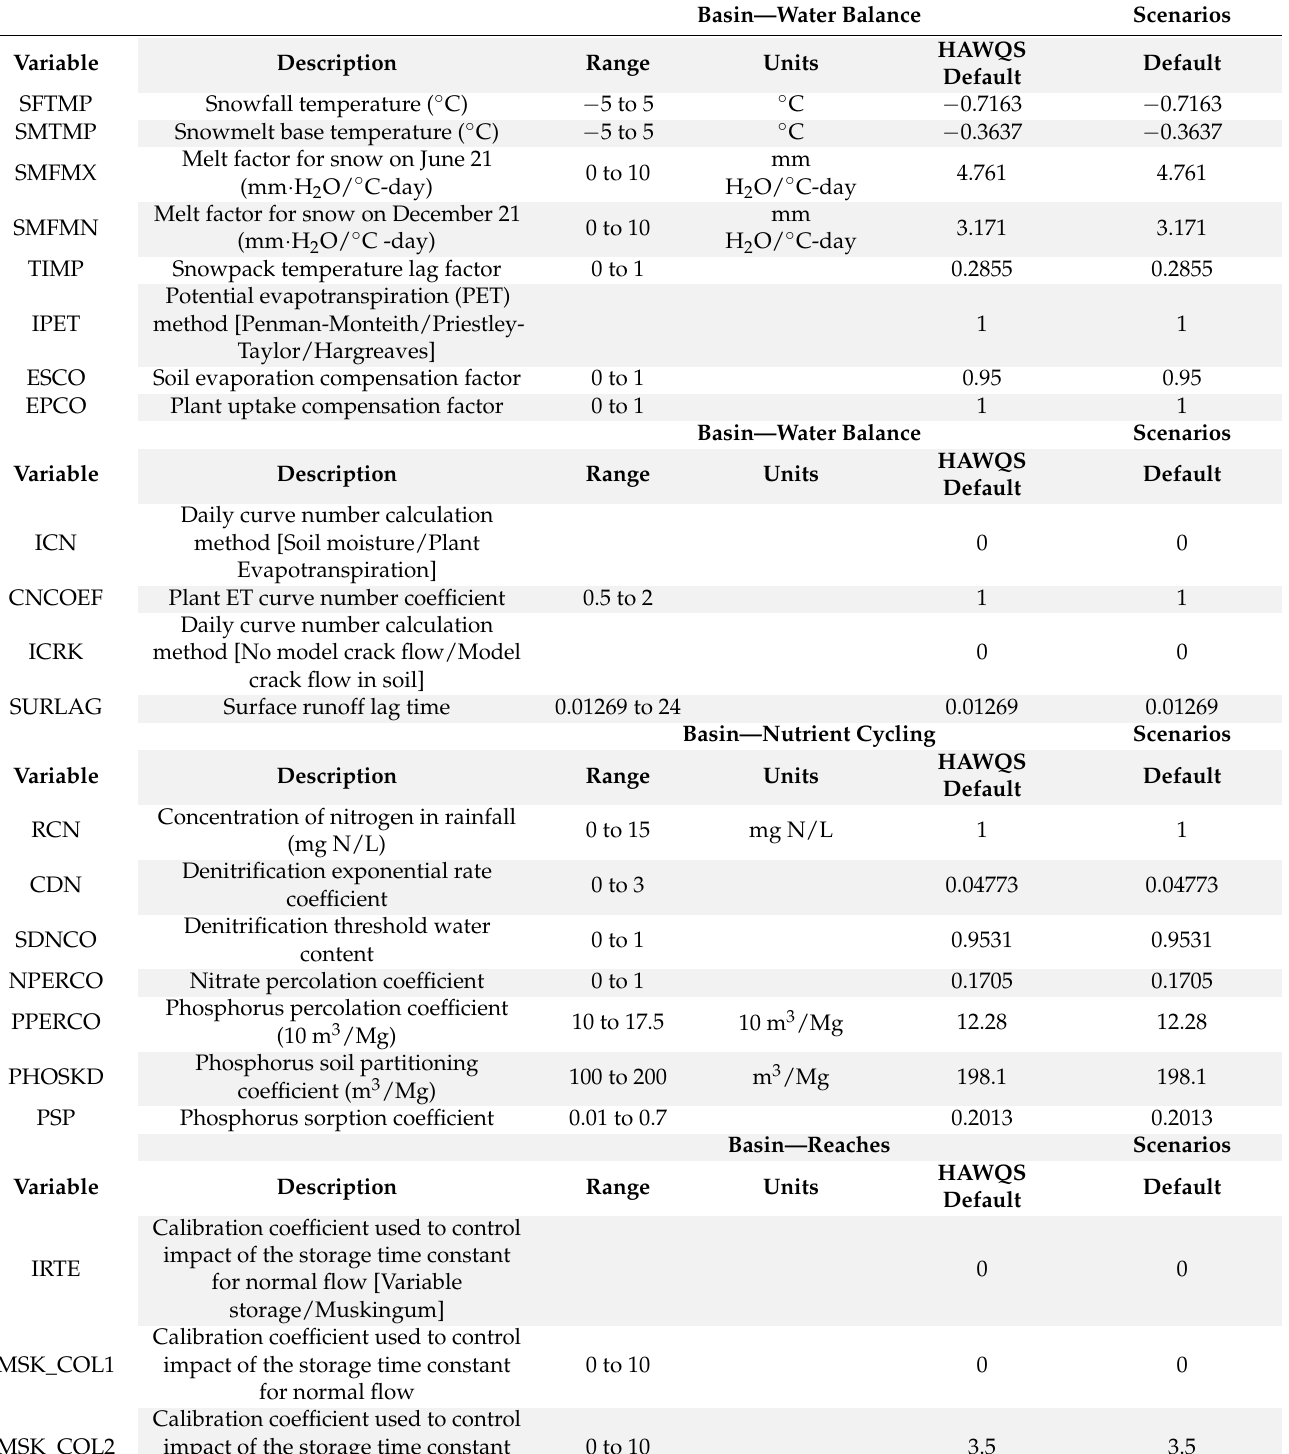
Table A5. SWAT model setup parameters.